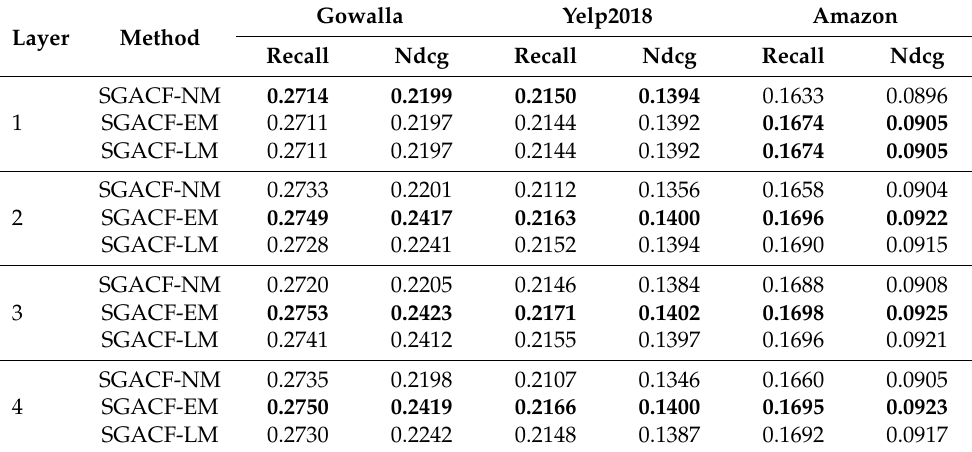
Table 1. Explore SGACF performance on three